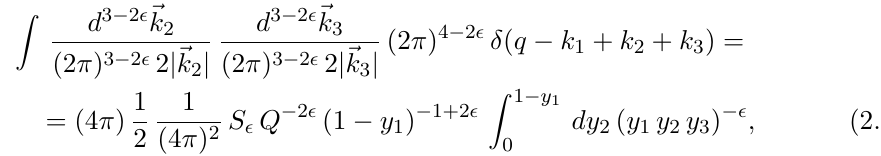
JHEP02(2021)076 . i